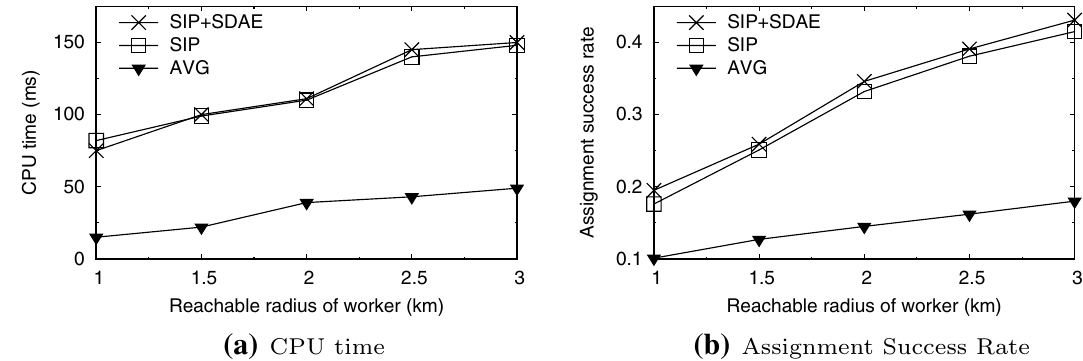
Fig. 5 Performance of preference modeling: effect of r